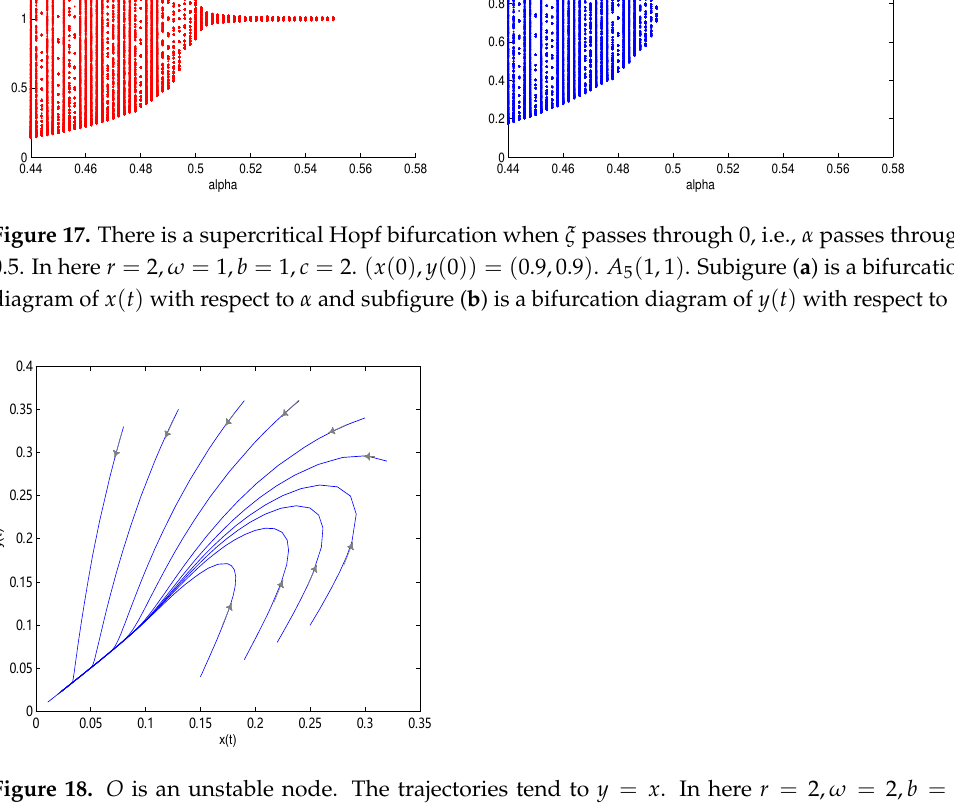
Figure 18. O is an unstable node. The trajectories tend to y = x . In here r = 2, ω = 2, b = 1, c = 2, α =